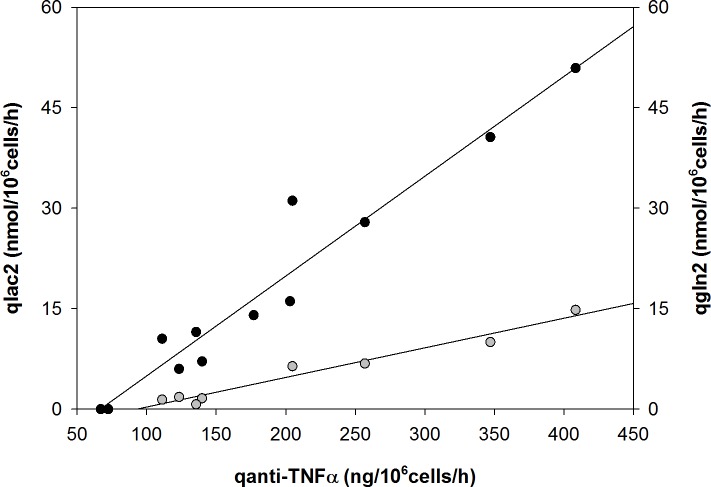
Relationship between qanti-TNFα and q (lactate: ●, and glutamine: ●; both after shift).